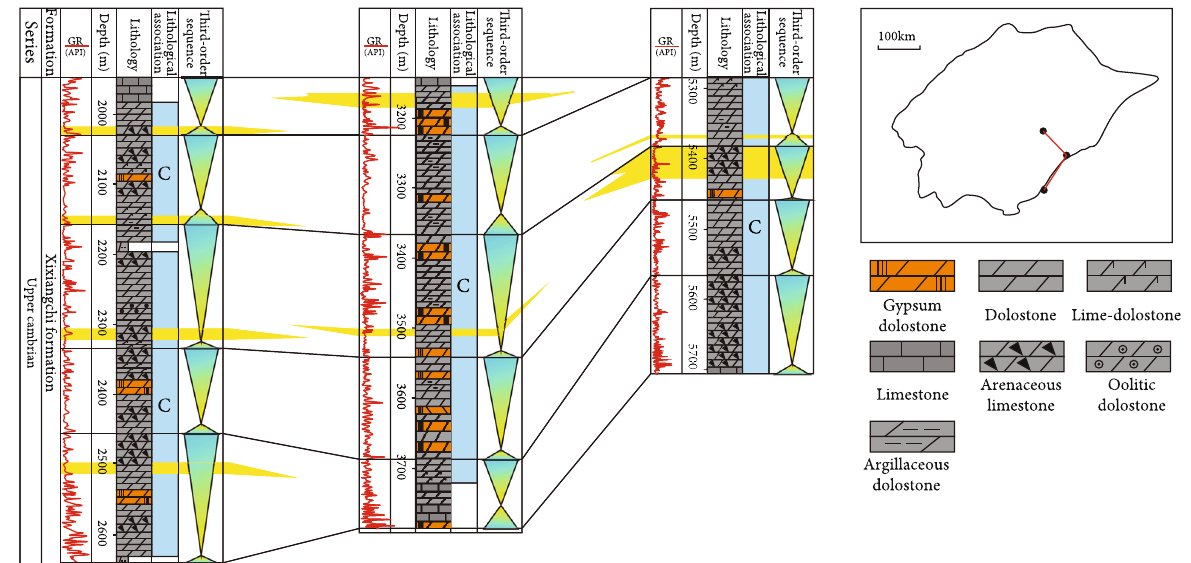
Figure 15: Well-tie section showing vertical reservoir distribution of the Xixiangchi Formation, Sichuan Basin.